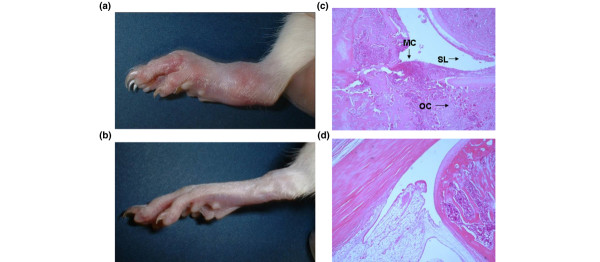
Morphological features and histopathological aspects of the hindlimb in AIA rats. (a) Control rats and (b) rats treated with tetrathiomolybdate (TM). Joint swelling, redness, and edema of the foot in AIA was clearly reduced with TM administration at day 17 after immunization. Histopathological studies using hematoxylin and eosin staining of the foot joint also revealed (c) a marked decrease of synovial inflammatory cell infiltrate and synovial lining hyperplasia compared with (d) control rats. (c), (d) Original magnification × 40. AIA, adjuvant-induced arthritis; MC, monocyte; SL, synovial lining cell; OC, osteoclast.